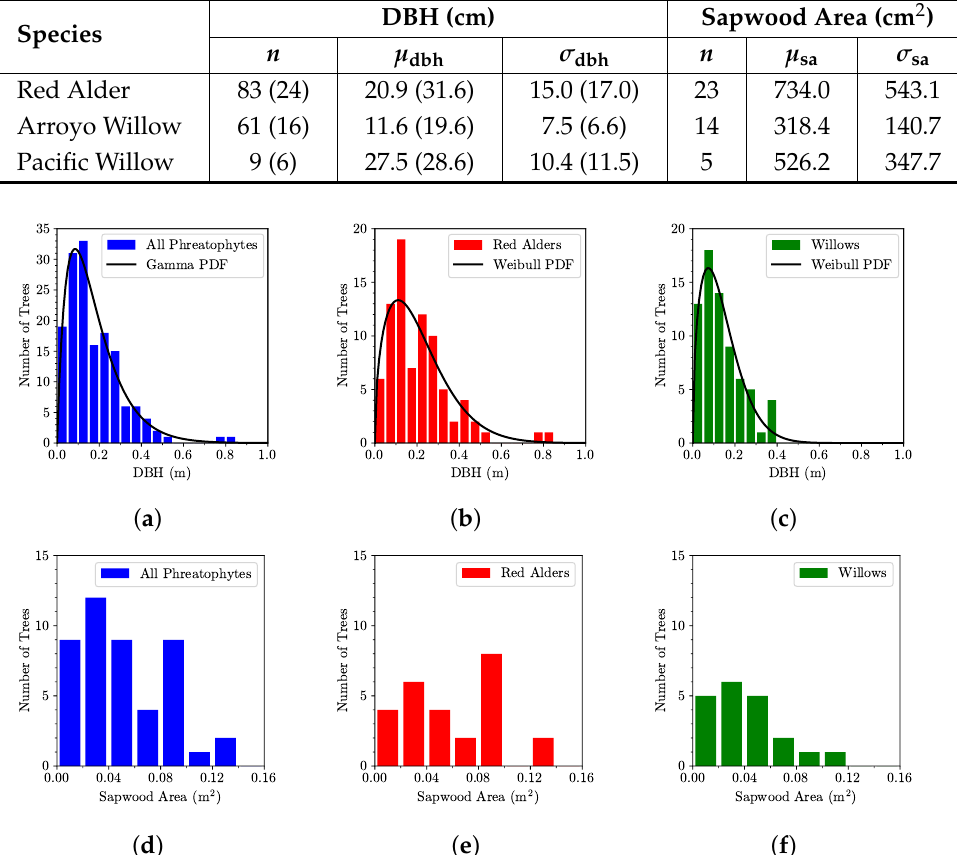
Table 1. Statistics of surveyed phreatophytes within the six sample plots. The values in parenthe- ses indicate the subsamples that were selected for coring to obtain direct measurements of bark thicknesses and heartwood/pith radii for sapwood area estimation. DBH (cm)